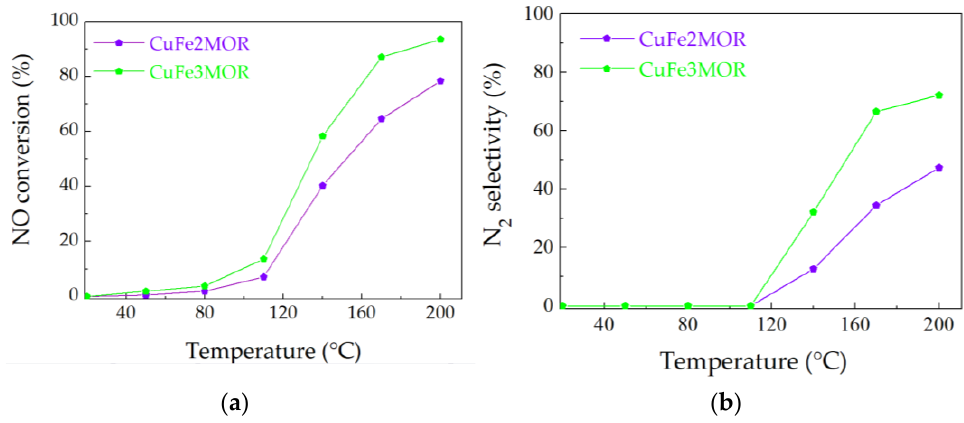
Figure 9. NO conversion ( a ) and selectivity ( b ) over CuFe2MOR and CuFe3MOR